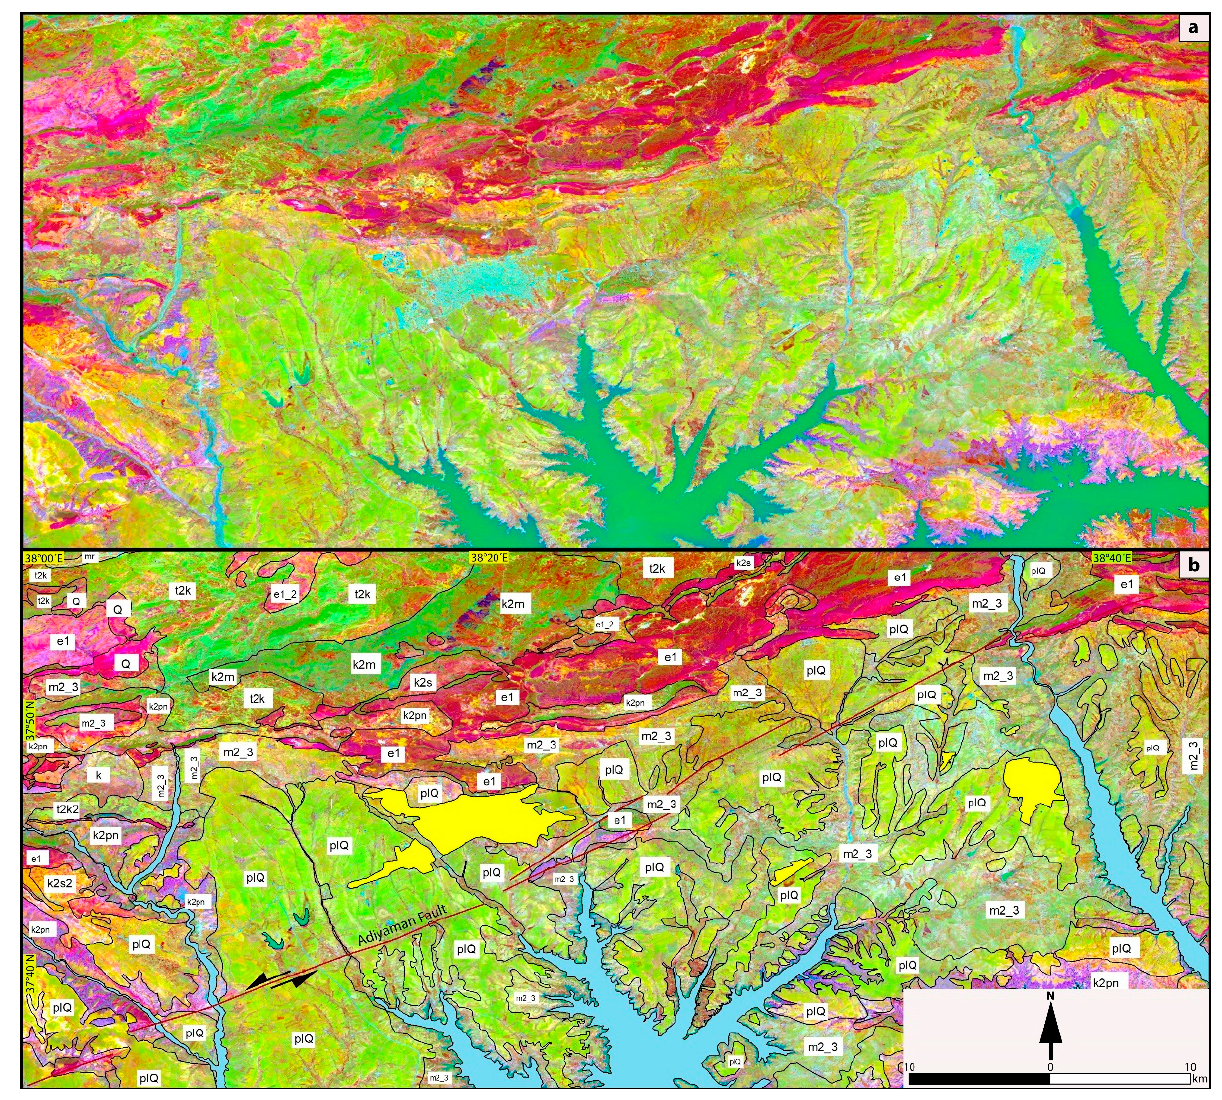
Figure 5. ( a ) Landsat 8 independent component analysis RGB-132 image. ( b ) ICA image with lithological polygons. Areas of settlements are defined by yellow polygons.